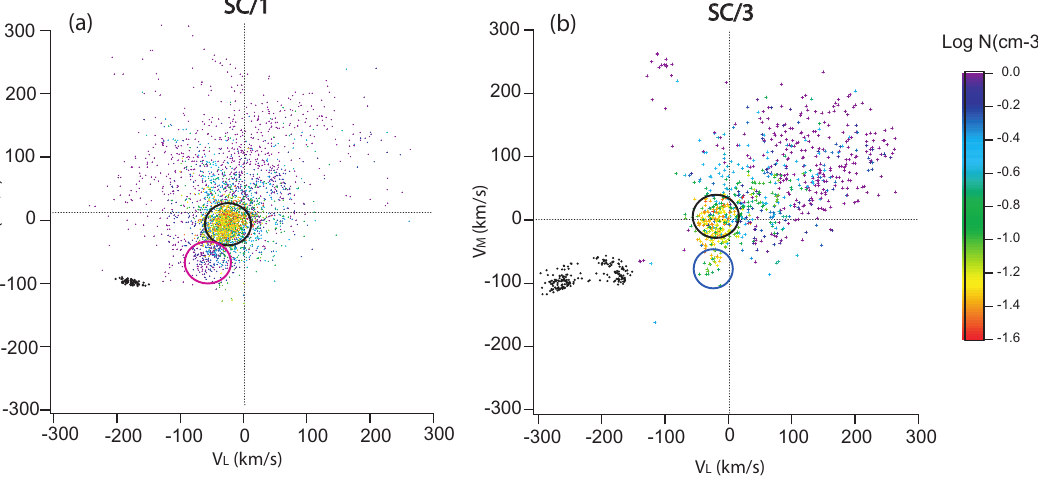
Fig. 8. Scatter plot of SC/1 (left) and SC/3 (right) ion flow velocity for all the magnetosphere and boundary layer passages. Color coding corresponds to the logarithm of the ion number density. The black dots are representative of magnetosheath flow. See the text for the description of